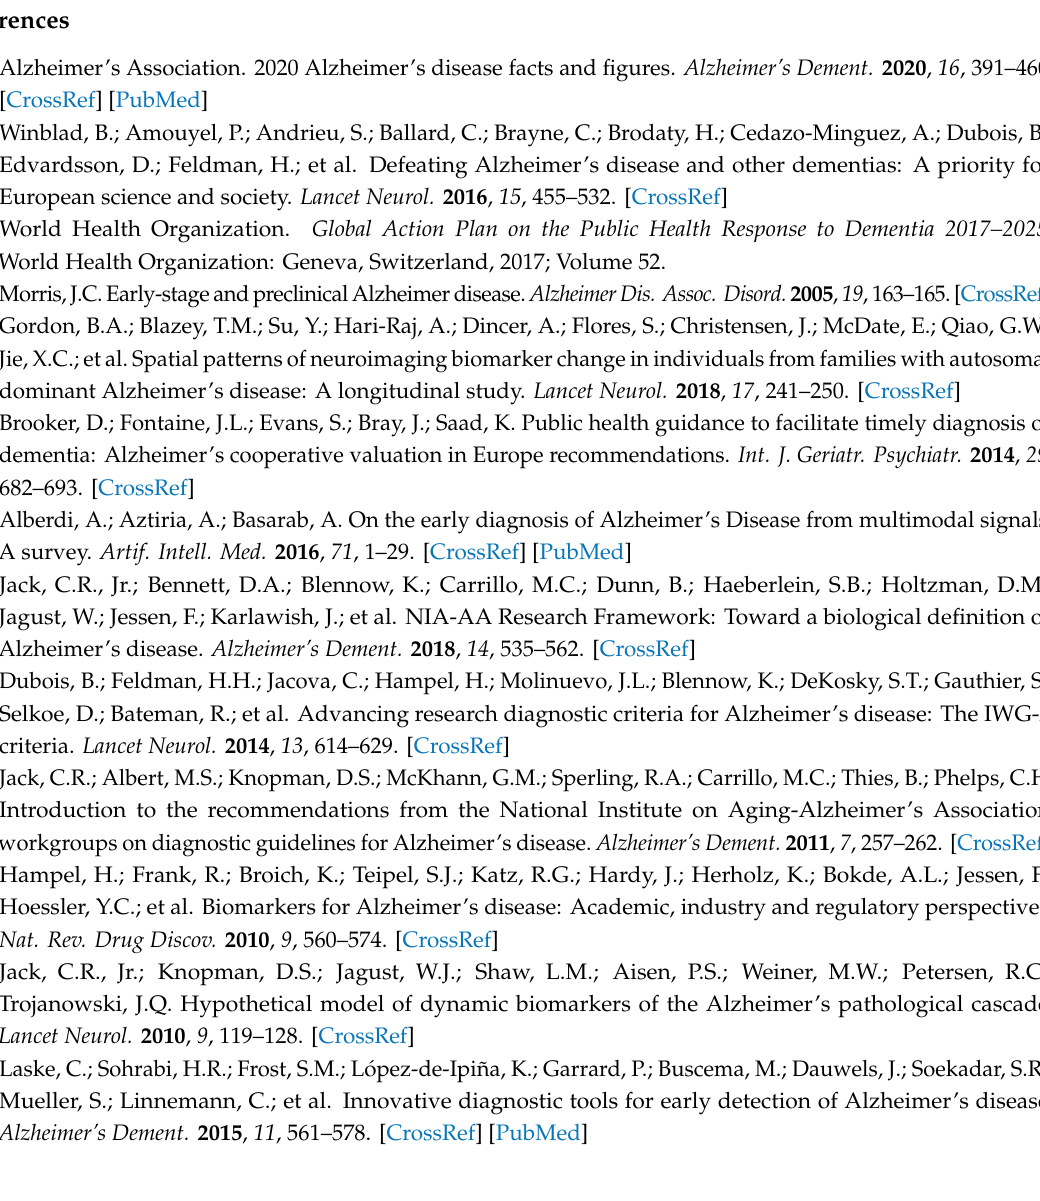
Table S1: Discriminant results by di ff erent classifiers using 5-fold CV based on six candidate wavelet